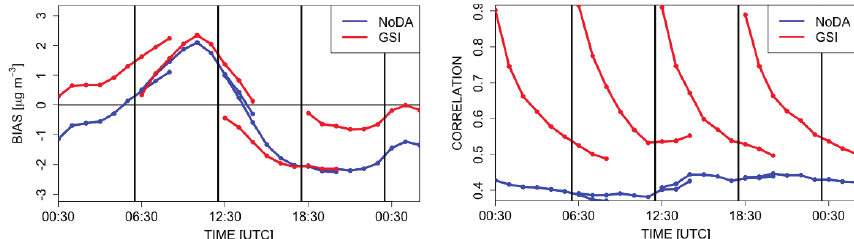
Figure 3. Bias (left) and spatial correlation (right) calculated for forecasts issued over a month-long period in summer 2012 for the North America domain with and without assimilation of surface observations of PM 2 . 5